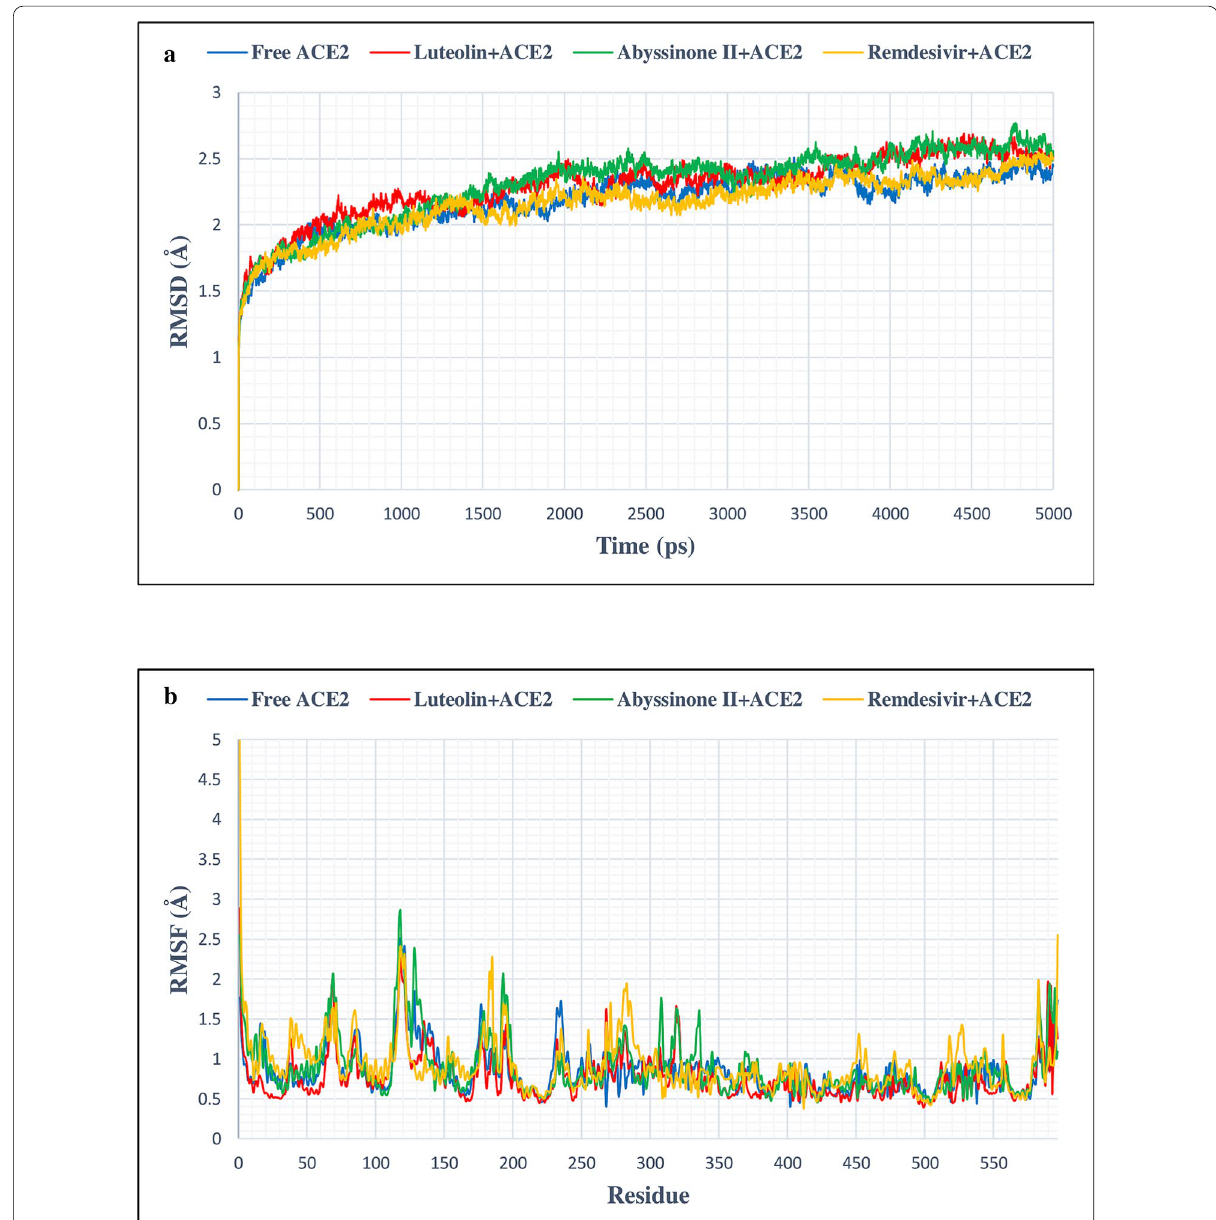
Fig. 8 a RMSD plot of 5 ns MD simulation for free and bound ACE2 complexed with C3/luteolin, C43/abyssinone II and Con-2/remdesivir, b RMSF plot of free and bound ACE2 complexed with C3/luteolin, C43/abyssinone II and